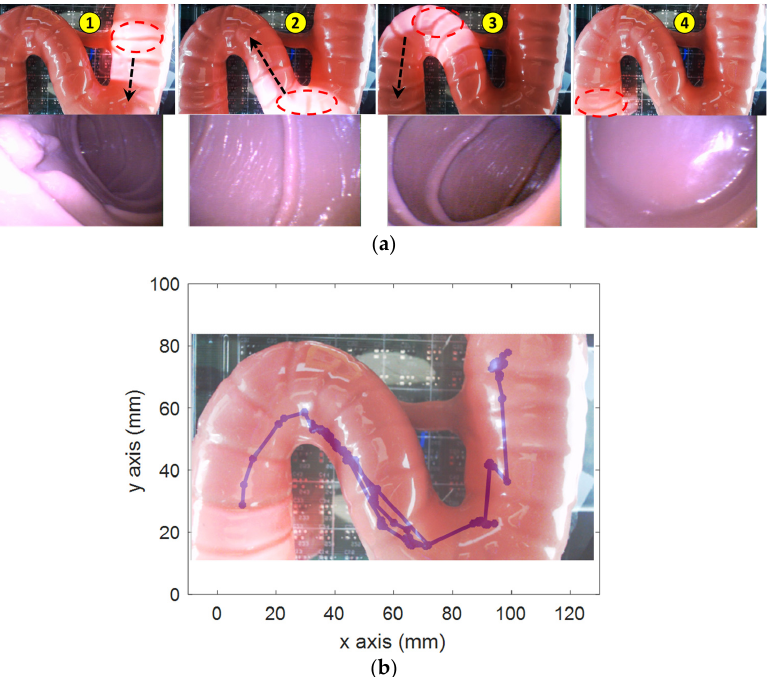
Figure 8. Demonstration of active locomotion in a small-bowel phantom. ( a ) Position of the CE in- side the phantom where the light from capsule camera (red dash line) exposes its current position and the extracted pill’s camera images corresponding to positions 1, 2, 3, and 4. The black arrow shows the moving direction. ( b ) Overlaid phantom photo and localization data. The purple dot and the curve represents the tracked position.